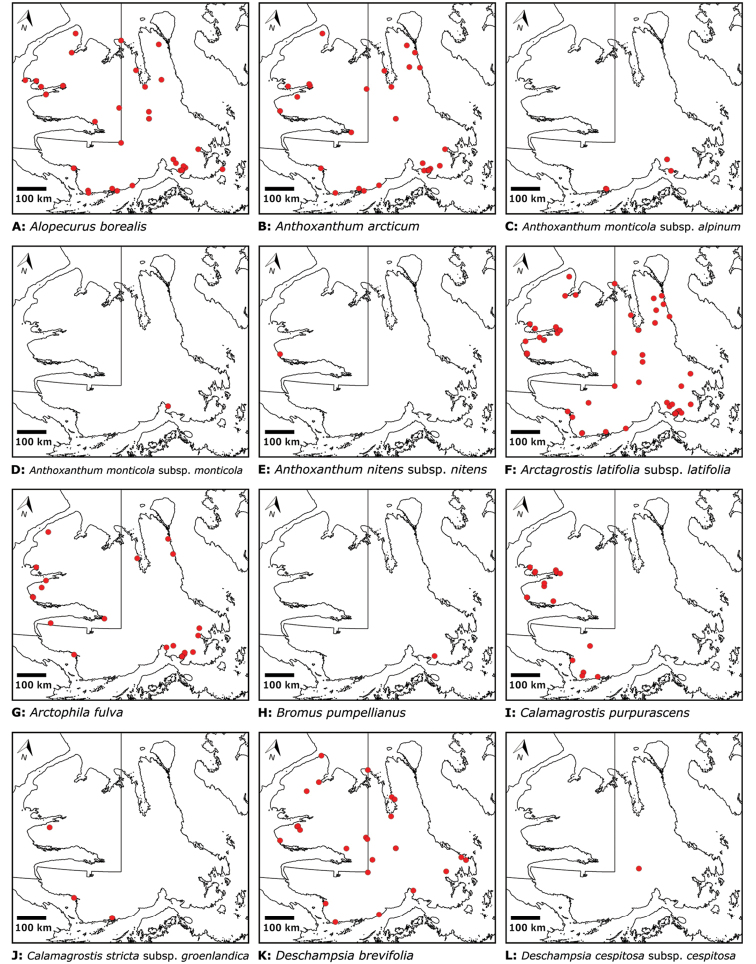
Species distribution maps. Poaceae: AAlopecurus
borealisBAnthoxanthum
arcticumCAnthoxanthum
monticola
subsp.
alpinumDAnthoxanthum
monticola
subsp.
monticolaEAnthoxanthum
nitens
subsp.
nitensFArctagrostis
latifolia
subsp.
latifoliaGArctophila
fulvaHBromus
pumpellianusICalamagrostis
purpurascensJCalamagrostis
stricta
subsp.
groenlandicaKDeschampsia
brevifoliaLDeschampsia
cespitosa
subsp.
cespitosa.